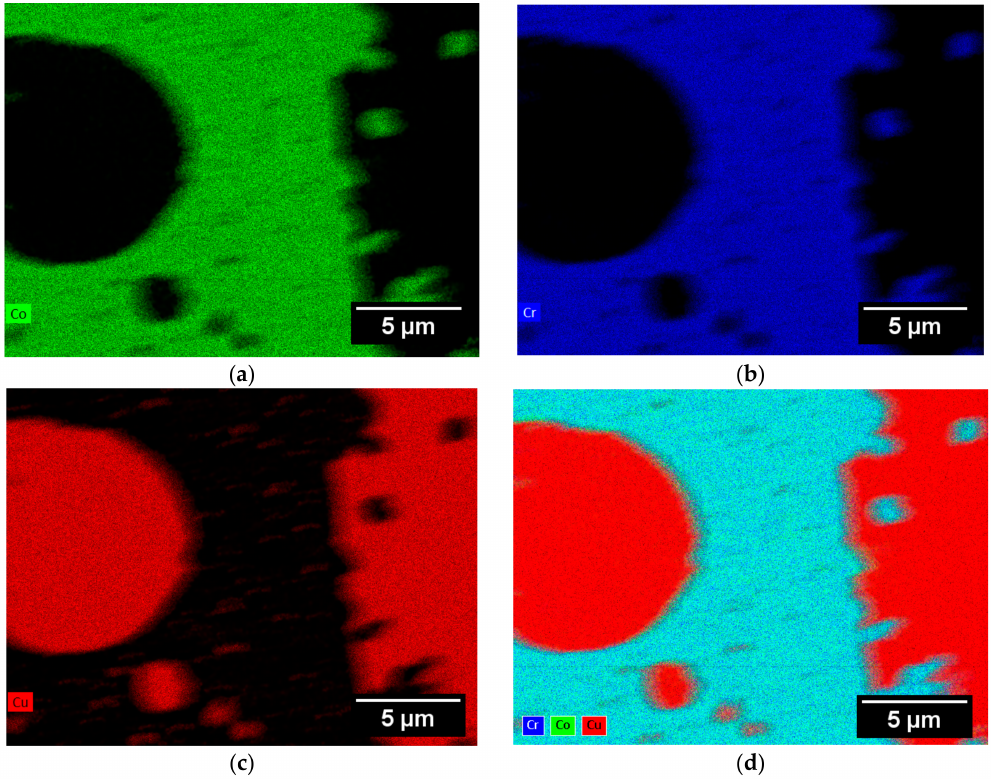
Figure 5. Energy dispersive X-ray spectroscopy (EDS) maps of the phase separated regions of the electromagnetically levitated and cast CoCrCu alloy. The colored regions correspond to the atomic composition present in the material: ( a ) Cobalt only ( b ) Chromium only ( c ) Copper only ( d ) Map of all elements in the system.